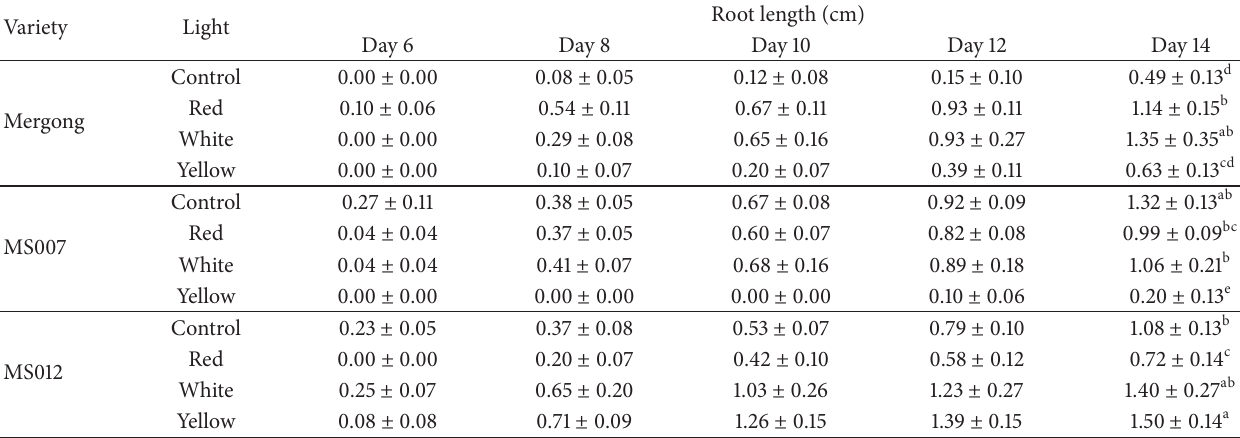
Table 10: Mean root length in three varieties treated with red, white, and yellow lights from day 6 to day 14 in mist-chamber propagation box.